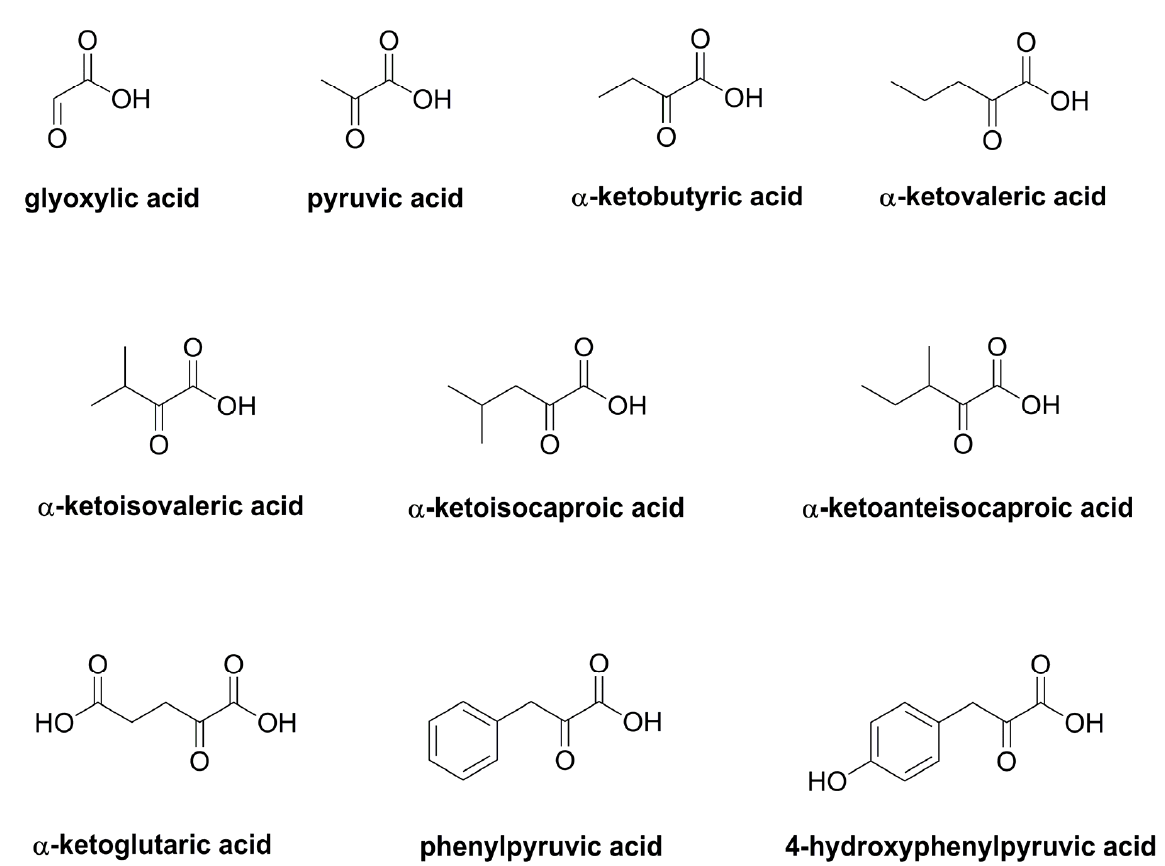
Figure 3. Chemical structures of quantified α -keto acids in blue fenugreek herb.